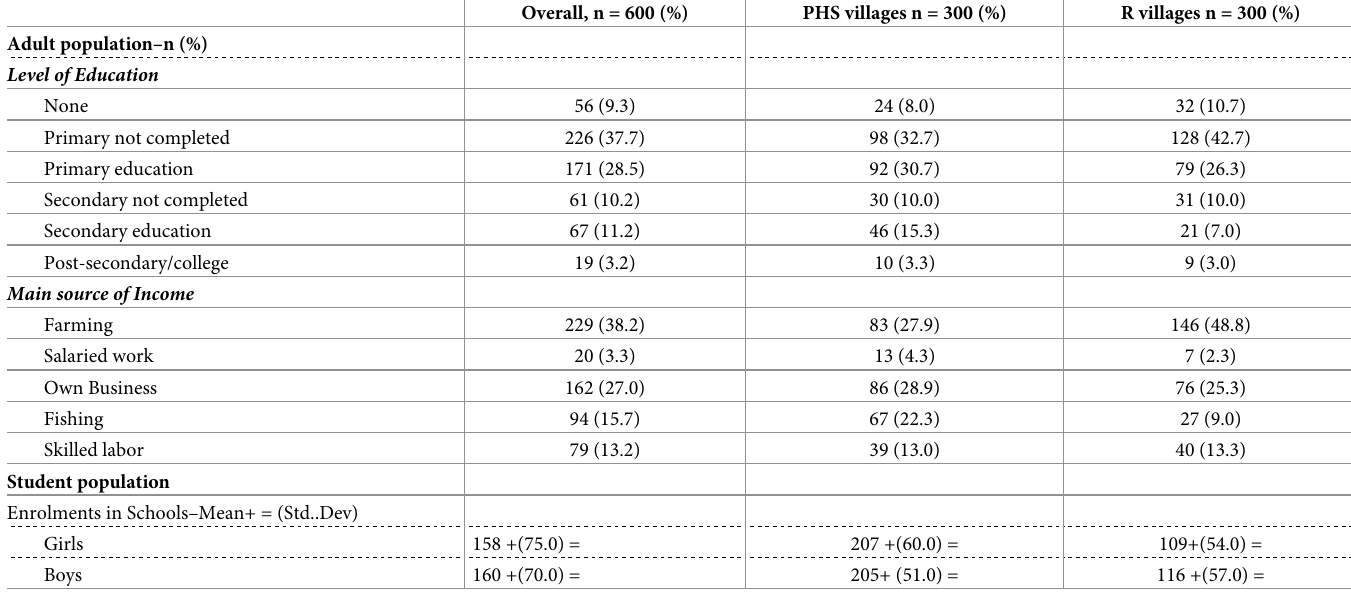
Table 1. General characteristics of the study